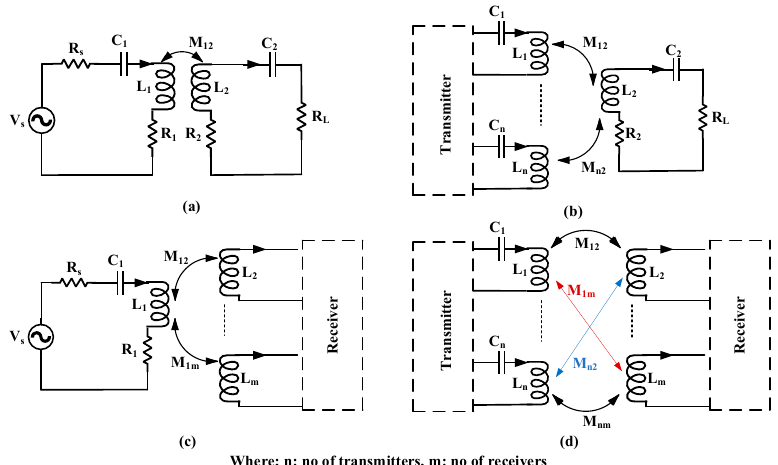
Figure 2. Various cases of pad implementation in DIPT system: ( a ) STSR, ( b ) MTSR, ( c ) STMR, and ( d ) MTMR.